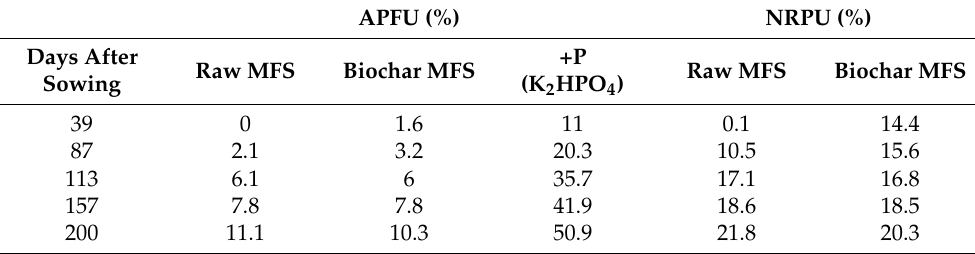
Table 3. Apparent P fertiliser recovery and net relative P